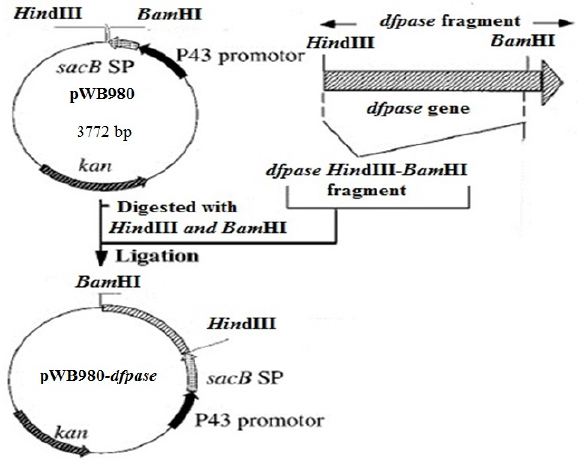
Figure 1 . Construction of pWB980- dfpase plasmid. The dfpase gene was inserted to the pWB980 plasmid between the Hind III and Bam HI restriction site. kan: kanamycin resistance marker. sacB SP: secretory signal sequence.